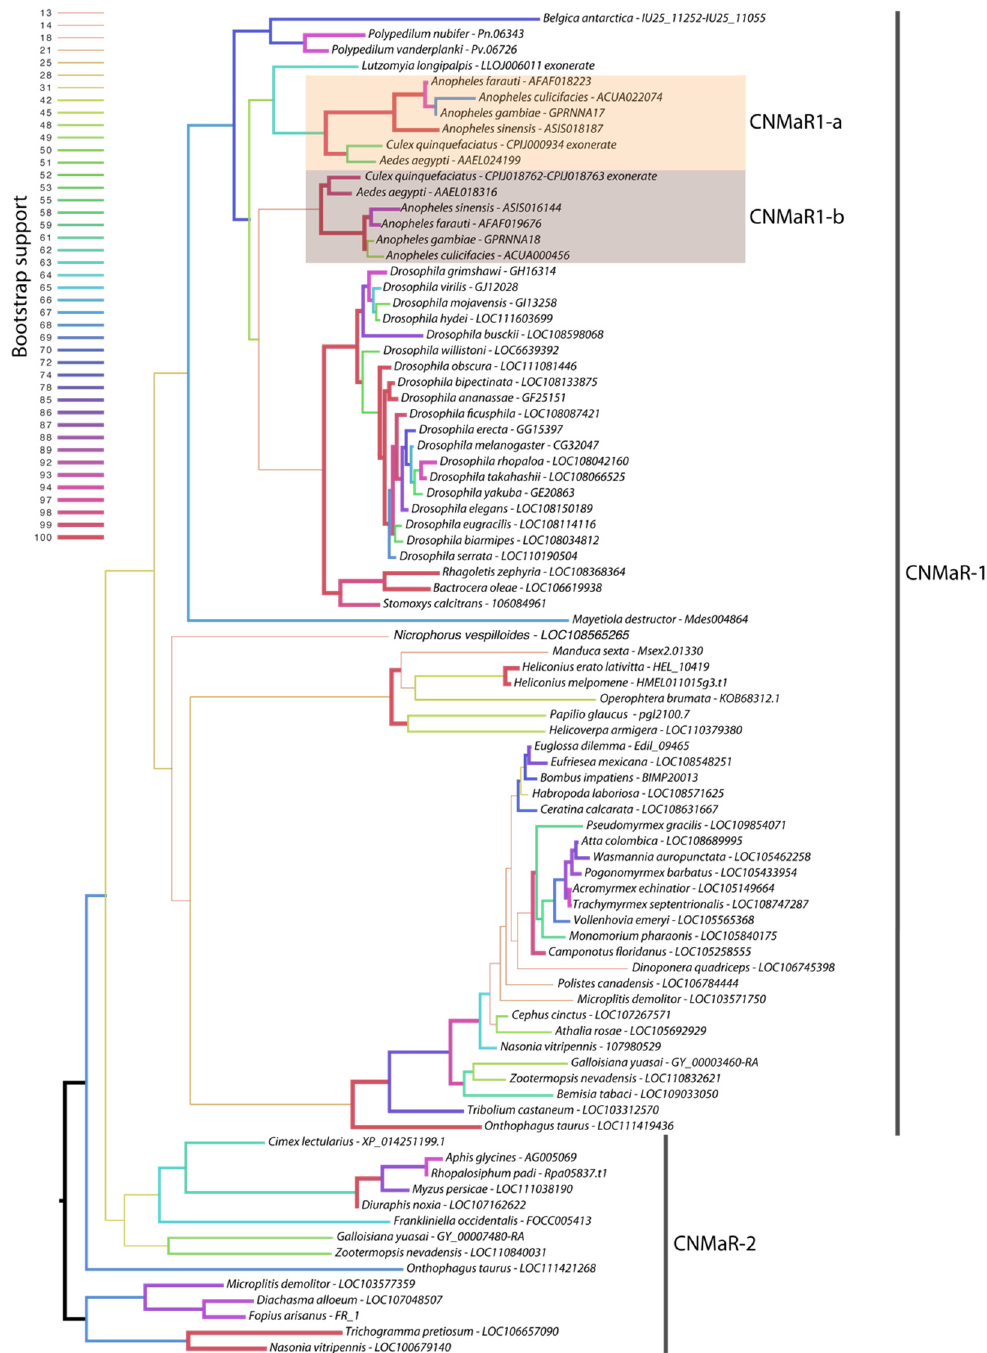
Figure 1. Maximum likelihood phylogenetic tree of CNMaR genes. At least two duplications of CNMaR have occurred in insects. The first duplication of CNMaR occurred prior to the divergence of the holo- and hemimetabolous insects as termites retain both CNMaR-1 and CNMaR-2 sequences. Sequences were aligned with MAFFT and phylogenetic tree constructed in RaXML with 100 boot- straps. Bootstrap support is listed at each node and is coded by branch color and weight as indicated by the legend. Sequence accession numbers are listed after each species name. Several sequences were obtained through alignment of coding sequences from closely related sequences with complete 7 transmembrane domains to genomic regions encoding partial sequences. These are indicated by tips labeled “exonerate.”.